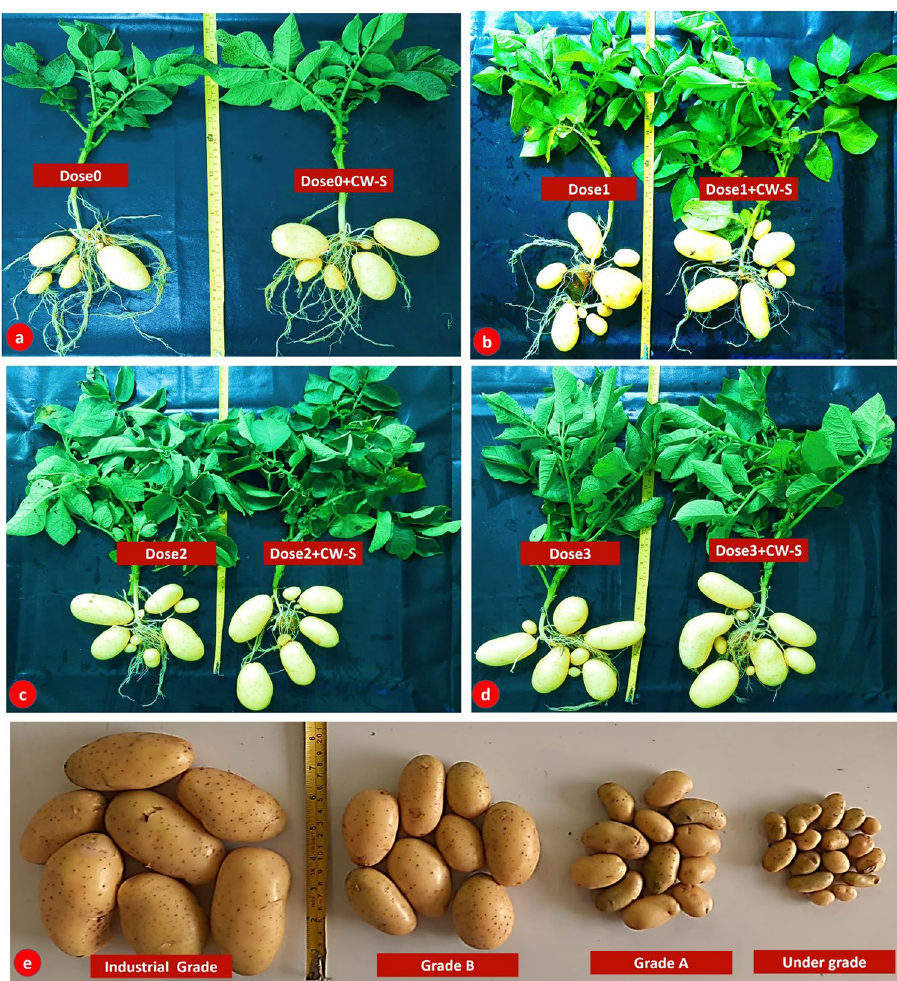
Figure 8. A comparison of CW-S and control in terms of yield and grade of potatoes. ( a ) Dose0 and CW-S. ( b ) Dose1 and CW-S. ( c ) Dose2 and CW-S. ( d ) Dose3 and CW-S. ( e ) A comparison of various